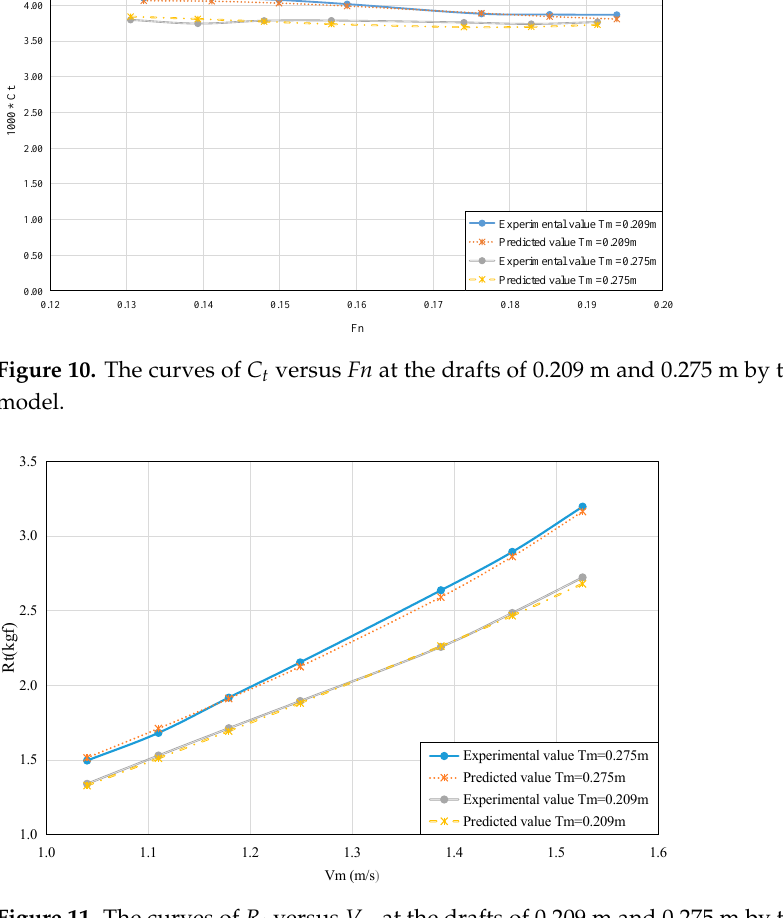
Figure 13. The ship resistance prediction results of the SVM and RBFNN models at the draft = 0.209 m.